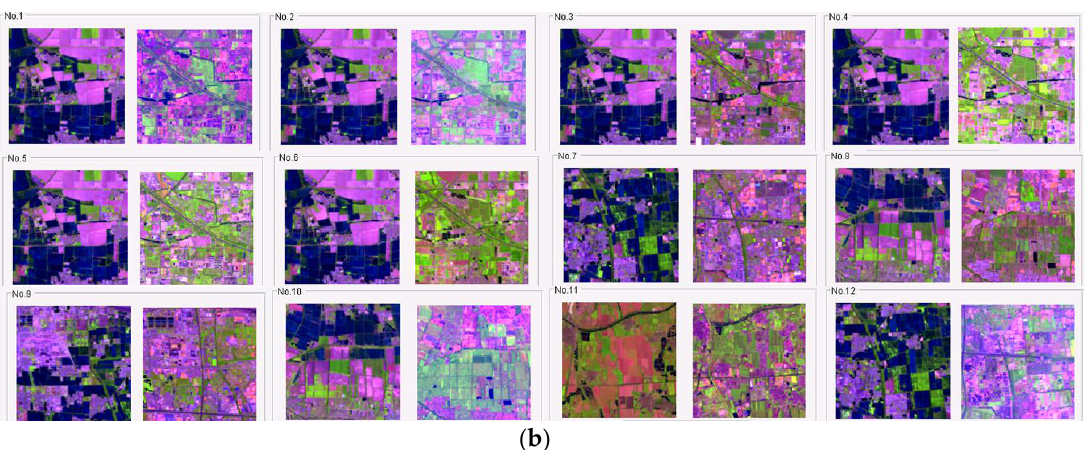
Figure 8. Query by example: looking for “WAT2BUI” in a database of remote sensing images. ( a ) The target pair of query images. ( b ) Pairs of images retrieved using the proposed method based on Multi-all features. The 12 most similar pairs of images are shown.